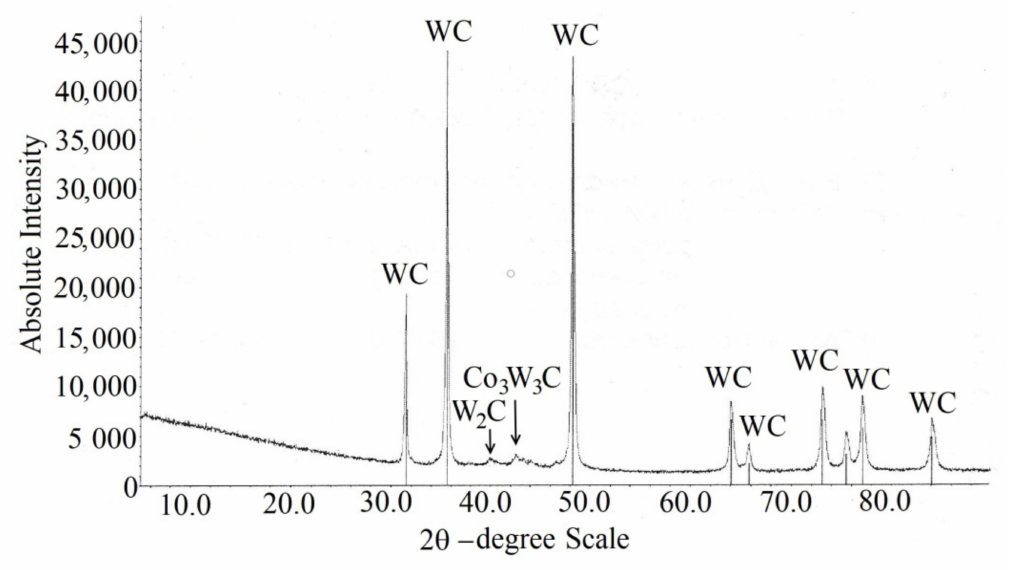
Figure 9. The X-ray diffraction pattern of coating of the sample of batch